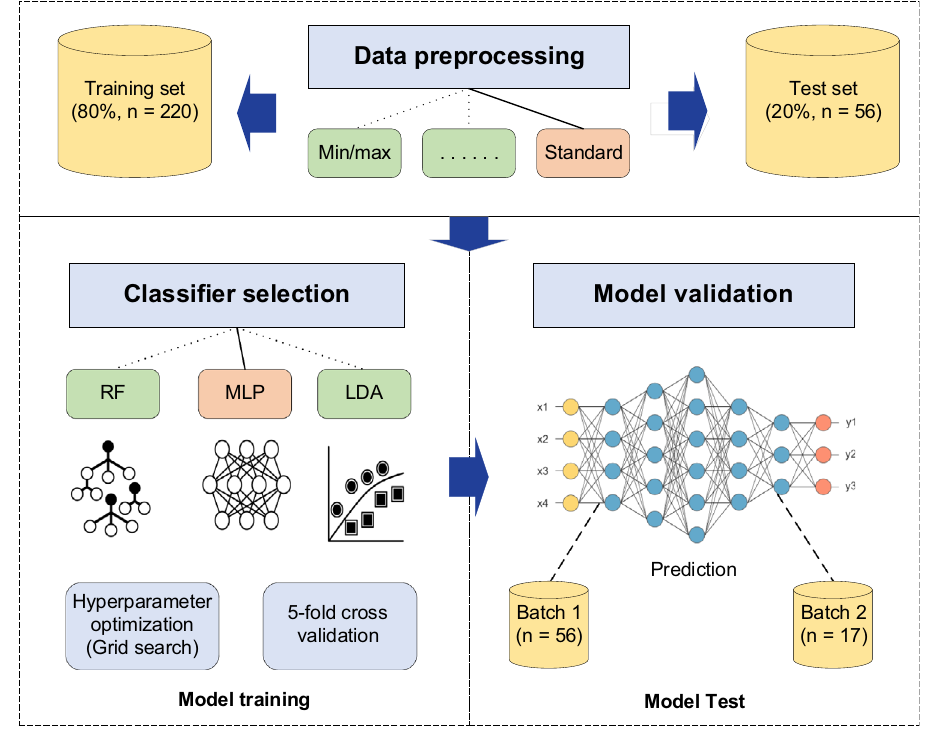
Fig. 6 Diagram of the machine learning work fl ow. A fl owchart for building tea geographic origin discrimination model is described, including data preprocessing, feature selection, hyperparameter optimization and model